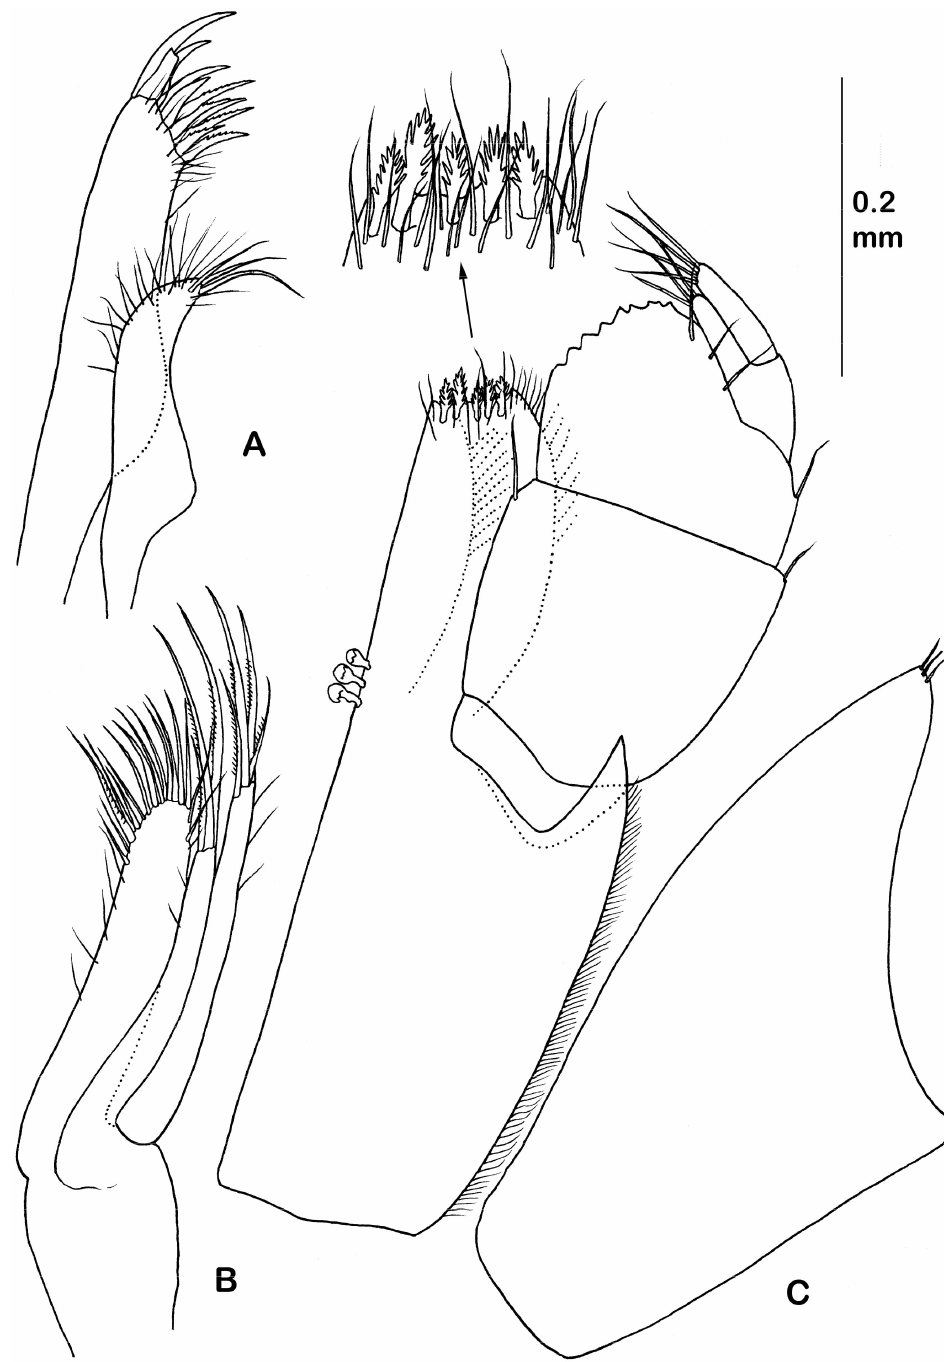
Figure 5. Eurycope producta GO Sars, 1868. Male (ZMH K-45592): ( A ) maxilla I; ( B ) maxilla II; ( C )